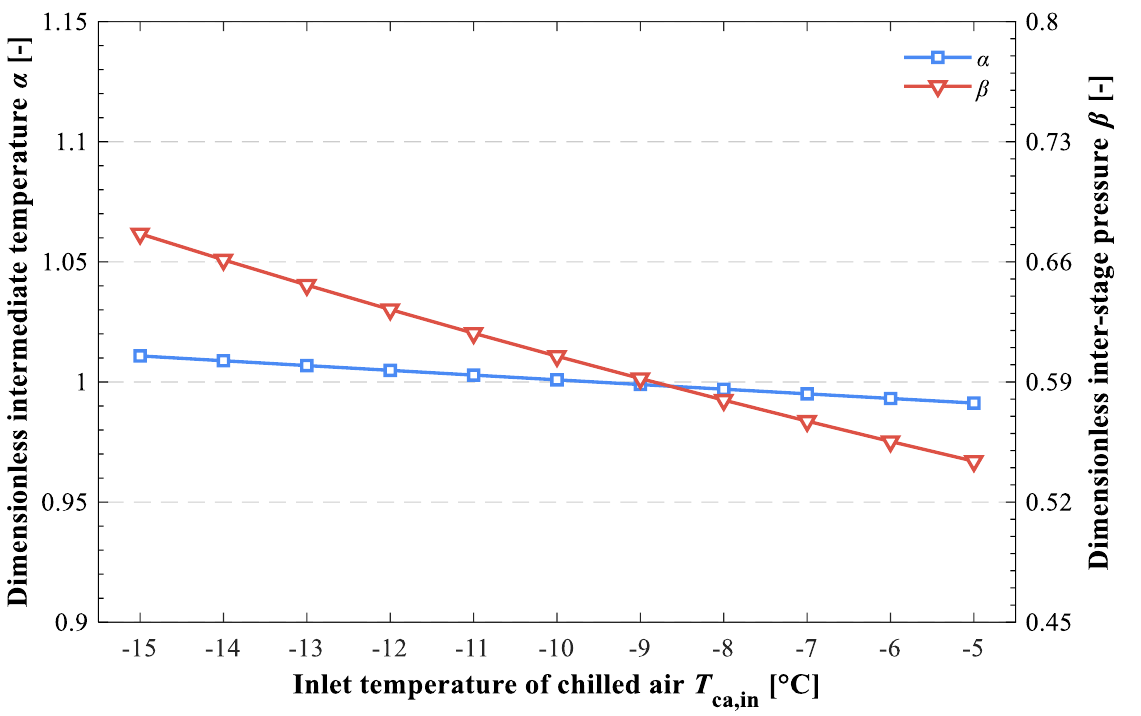
Figure 15. Effect of inlet temperature of chilled air on dimensionless optimum intermediate temper- ature and inter-stage pressure.